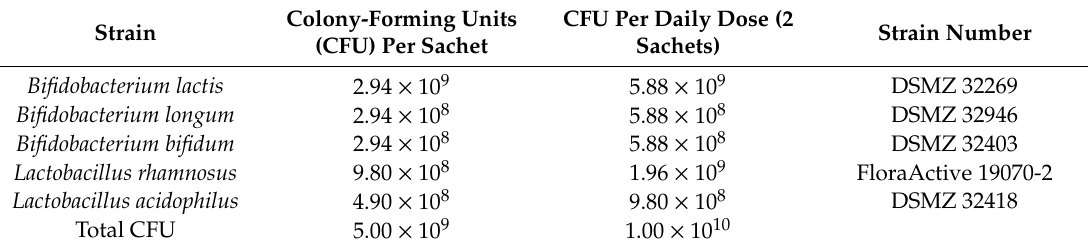
Table 1. Probiotic composition of a synbiotic preparation used in a clinical trial.